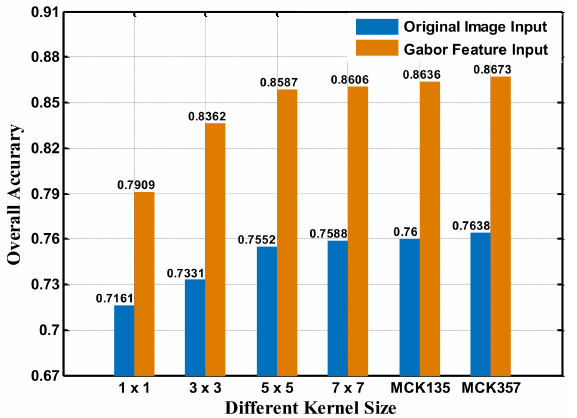
Figure 10. Effect of the convolution kernels with different sizes on the overall accuracy